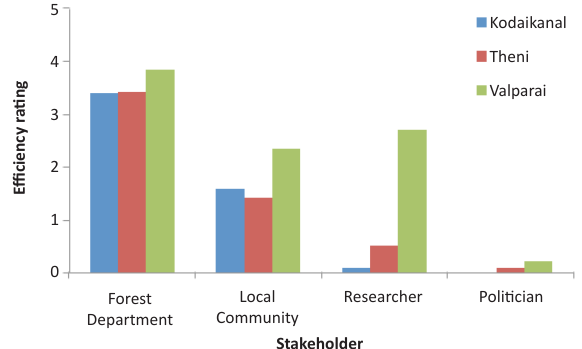
Figure 2. Stakeholder efficiency in biodiversity conservation as per overall ratings at three areas (Kodaikanal, Theni and Valparai) in the Western Ghats.